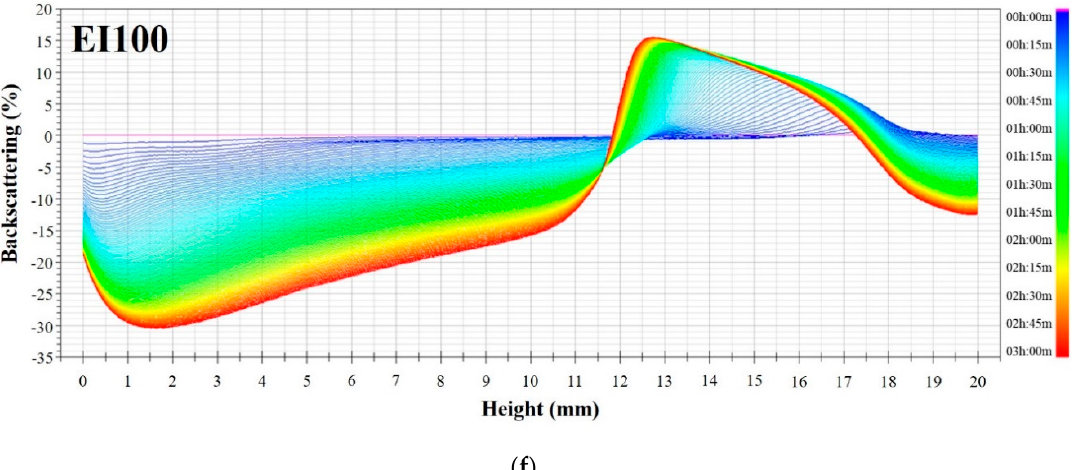
Figure 2. Backscattering profiles of emulsion prepared with interaction between porcine myofibrillar protein and extracted edible insect protein: ( a ) EI0, ( b ) EI20, ( c ) EI40, ( d ) EI60, ( e ) EI80, and ( f ) EI100. Porcine myofibrillar protein was substituted by edible insect protein at 0, 20, 40, 60, 80, and 100% (EI0, EI20, EI40, EI60, EI80, and EI100, respectively).